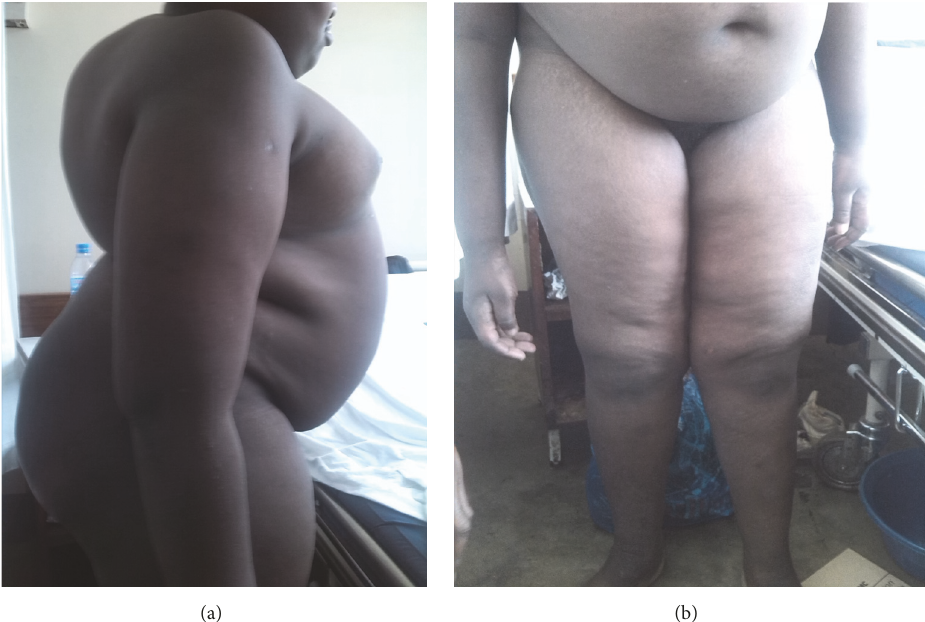
Figure 1: The clinical photos showed Kyphoscoliosis and truncal obesity (a) and poor developed genitalia (b) in a 25-year-old male with Prada-Willi